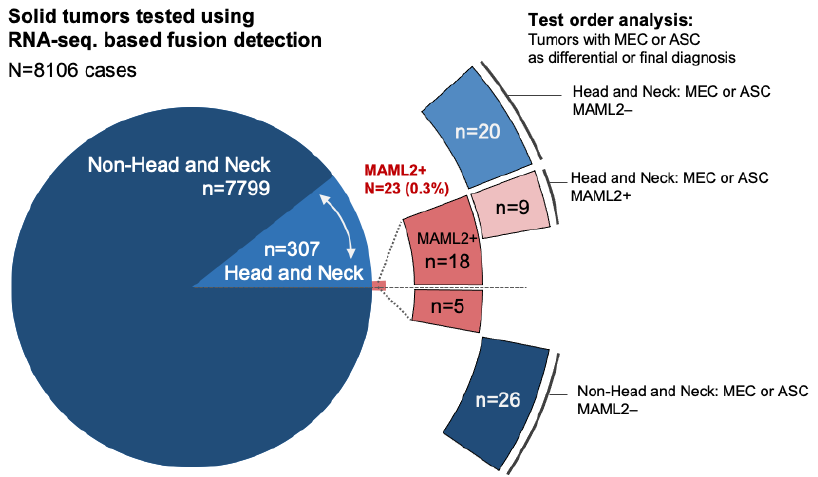
Figure 5. Relationship between analytical, primary site, and test order analysis cohorts. Abbreviations: MEC, mucoepidermoid carcinoma; ASC, adenosquamous carcinoma.